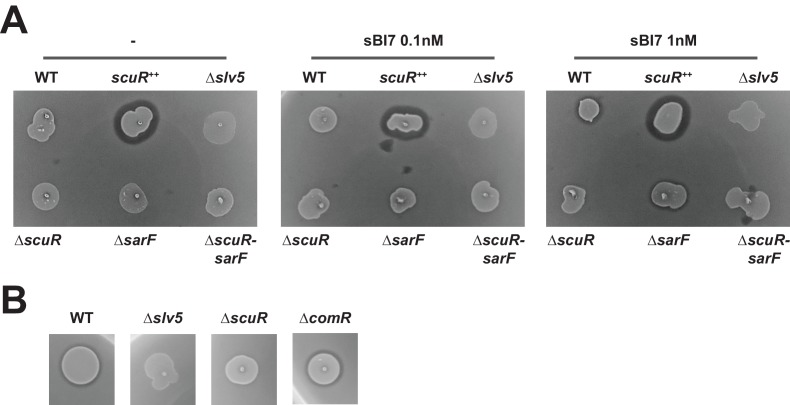
Bacteriocin production through ScuR activation with sBI7.(A and B) Bacteriocin inhibition assay of S. salivarius WT and scuR/sarF or comR mutant derivatives. The indicator strain (L. lactis) was embedded in the top soft agar layer and producer strains were spotted on top of the two agar layers., (A) sBI7 was supplemented or not into the bottom agar layer as stated. scuR ++ and bacteriocin null (Δslv5) mutants were used as positive and negative control, respectively. (B) the sBI7 pheromone was added at a final concentration of 1 µM. All spots are originated from the same plates but reorganized for optimal visualization.